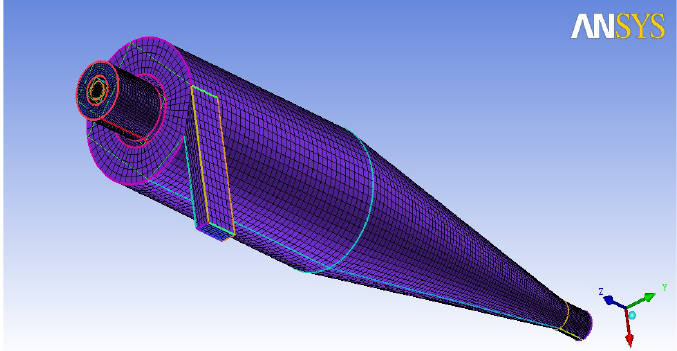
Figure 2. Mesh system used in the simulation.